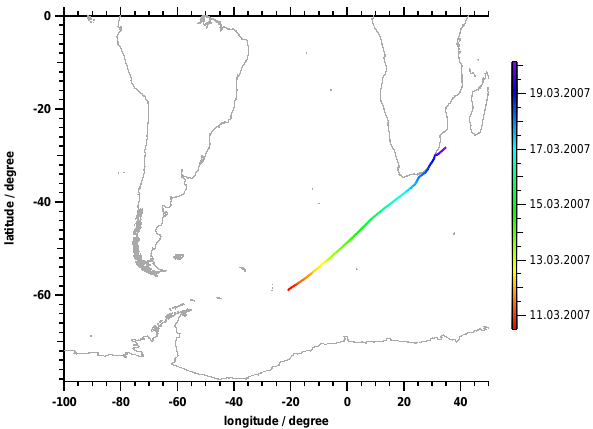
Figure 1. Ship track of the Marion Dufresne over the South At- lantic. The track is color coded with